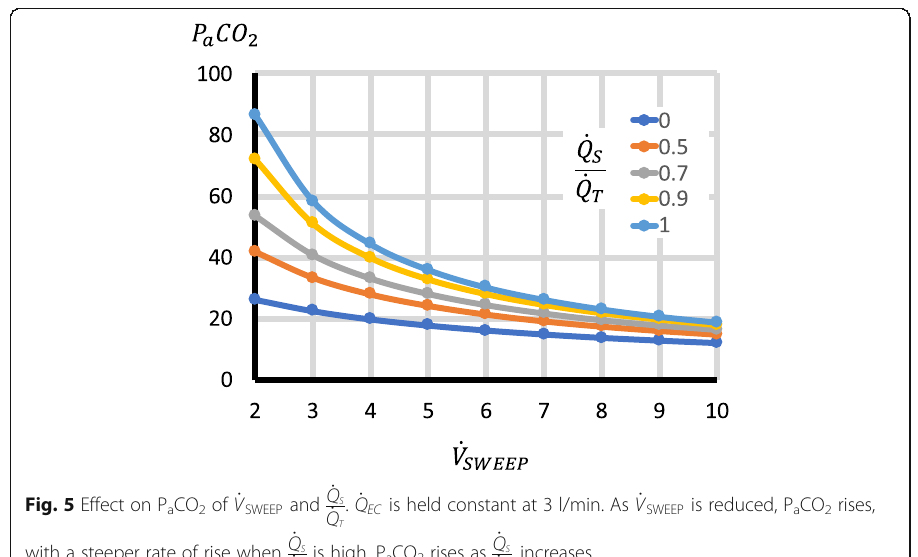
Fig. 5 Effect on P a CO 2 of _ V SWEEP and